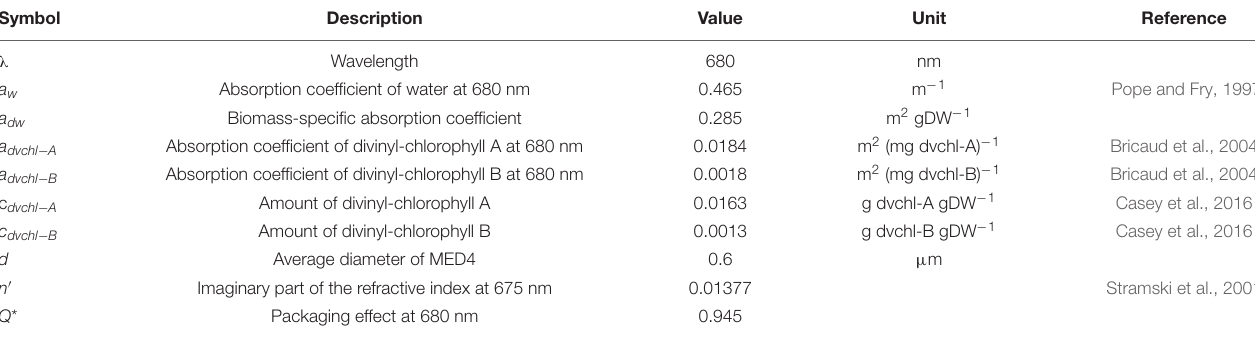
TABLE 1 | Coefficients and values used to calculate light absorption in